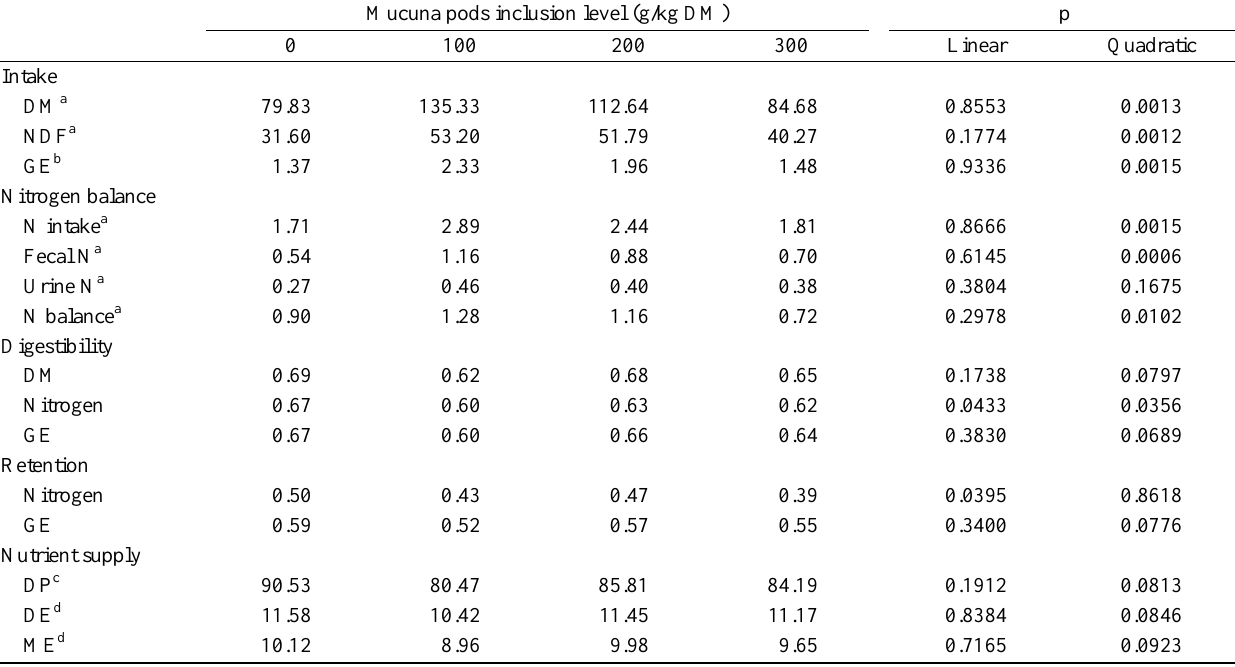
Table 2. Nutrient intake, retention and digestibility in diets containing M. pruriens pods Mucuna pods inclusion level (g/kg